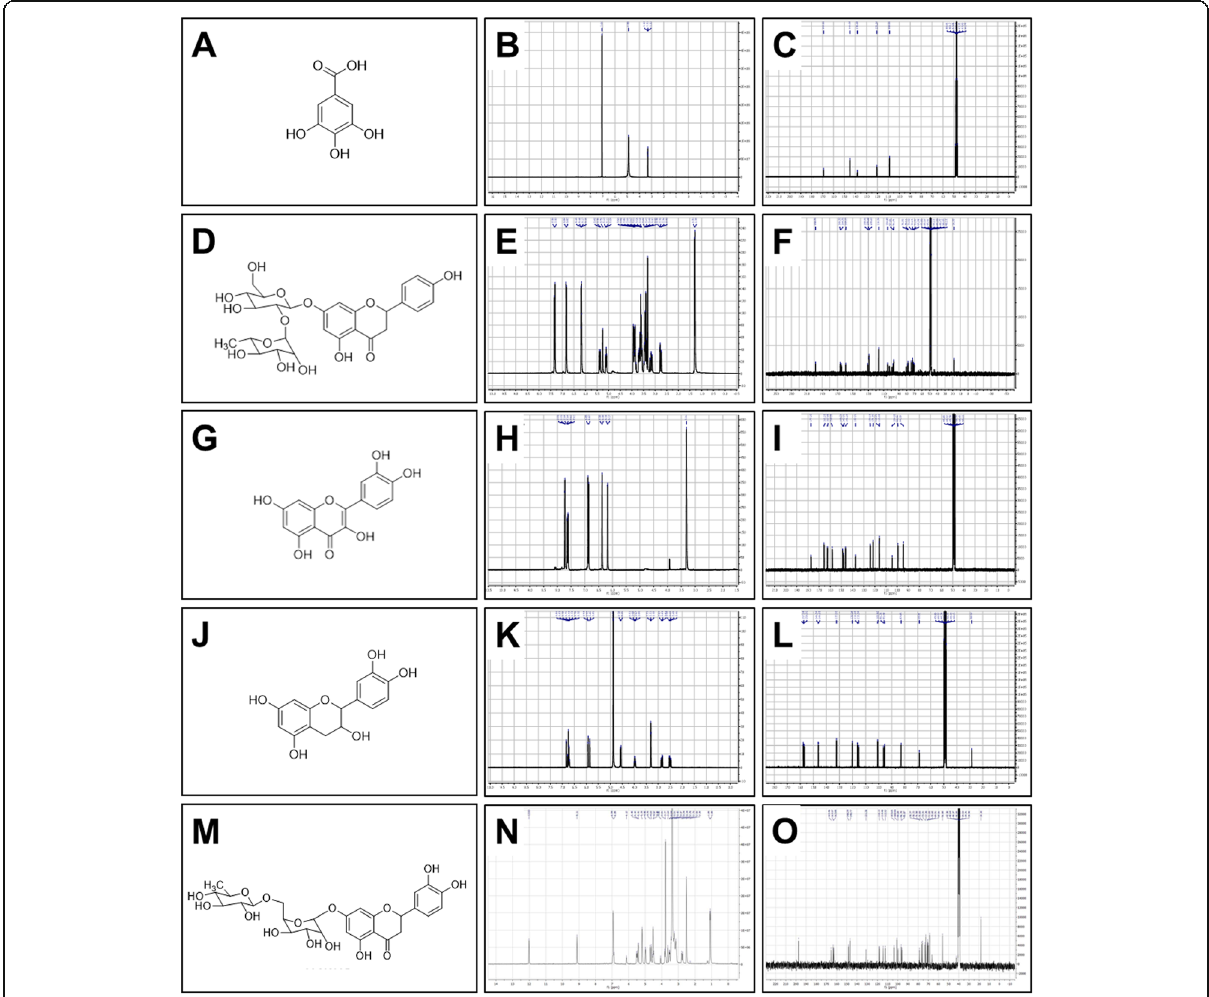
Fig. 3 1 H-NMR- and 13 C-NMR-derived structures and spectra of the compounds isolated from the Pg -YP-I-22C fraction. The five compounds isolated from the Pg -YP-I-22C fraction were identified by one- and two-dimensional nuclear magnetic resonance spectroscopy (1D and 2D NMR) techniques and through comparisons with data reported in the literature. a , d , g , j , and m . Chemical structures. b , e , h , k and n . Proton spectra of each compound. c , f , i , l , and o . 13 C spectra of each compound. a - c . Gallic acid. d - f . Naringin. g - i . Quercetin. j - l . Catechin. m - o .